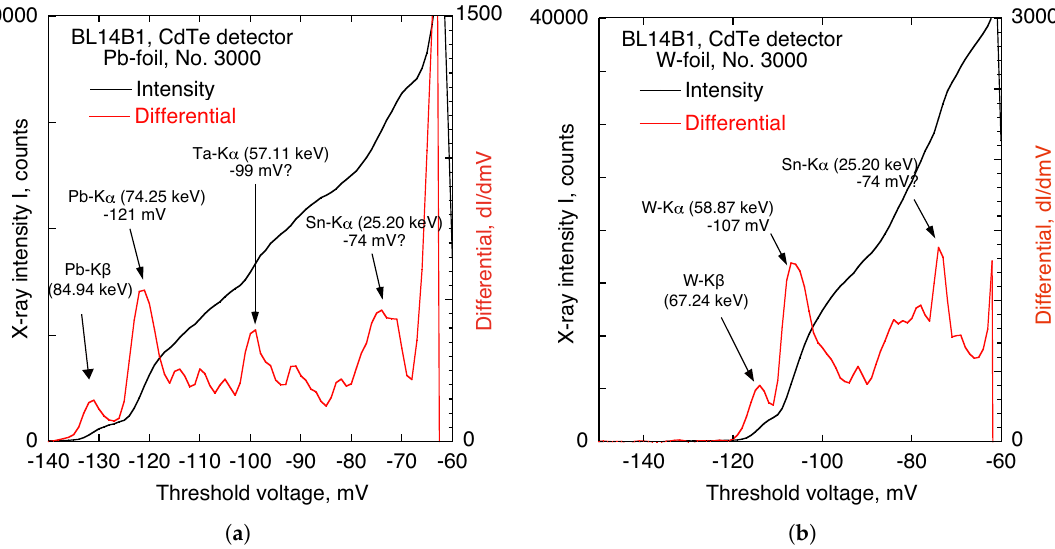
Figure 6. Relationship between the comparator threshold voltage and the X-ray energy. As an example, the result for the No. 3000 pixel is shown. The black line indicates the X-ray counts with the increase in the threshold voltage, and the red line indicates the difference using the threshold voltage. ( a ) Measured fluorescent X-rays for Pb-foil; ( b ) measured fluorescent X-rays for W-foil.